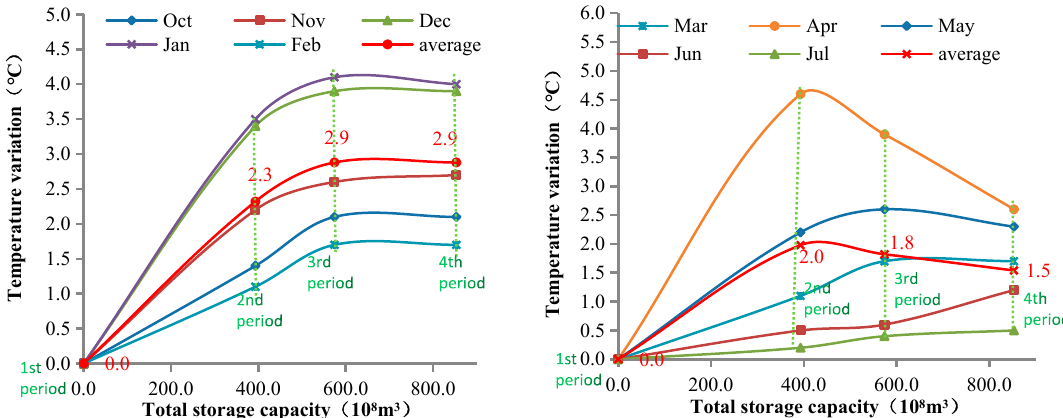
Figure 9. The difference between the discharged water temperature of the TGD and the natural water temperature. The total storage capacity is the sum of the storage capacity of each reservoir. In the 1st period, the total storage capacity is 0. In the 2nd period, the total storage capacity is 393 × 10 8 m 3 . In the 3rd period, the total storage capacity is 574 × 10 8 m 3 . In the 4th period, the total storage capacity is 853 × 10 8 m 3 .